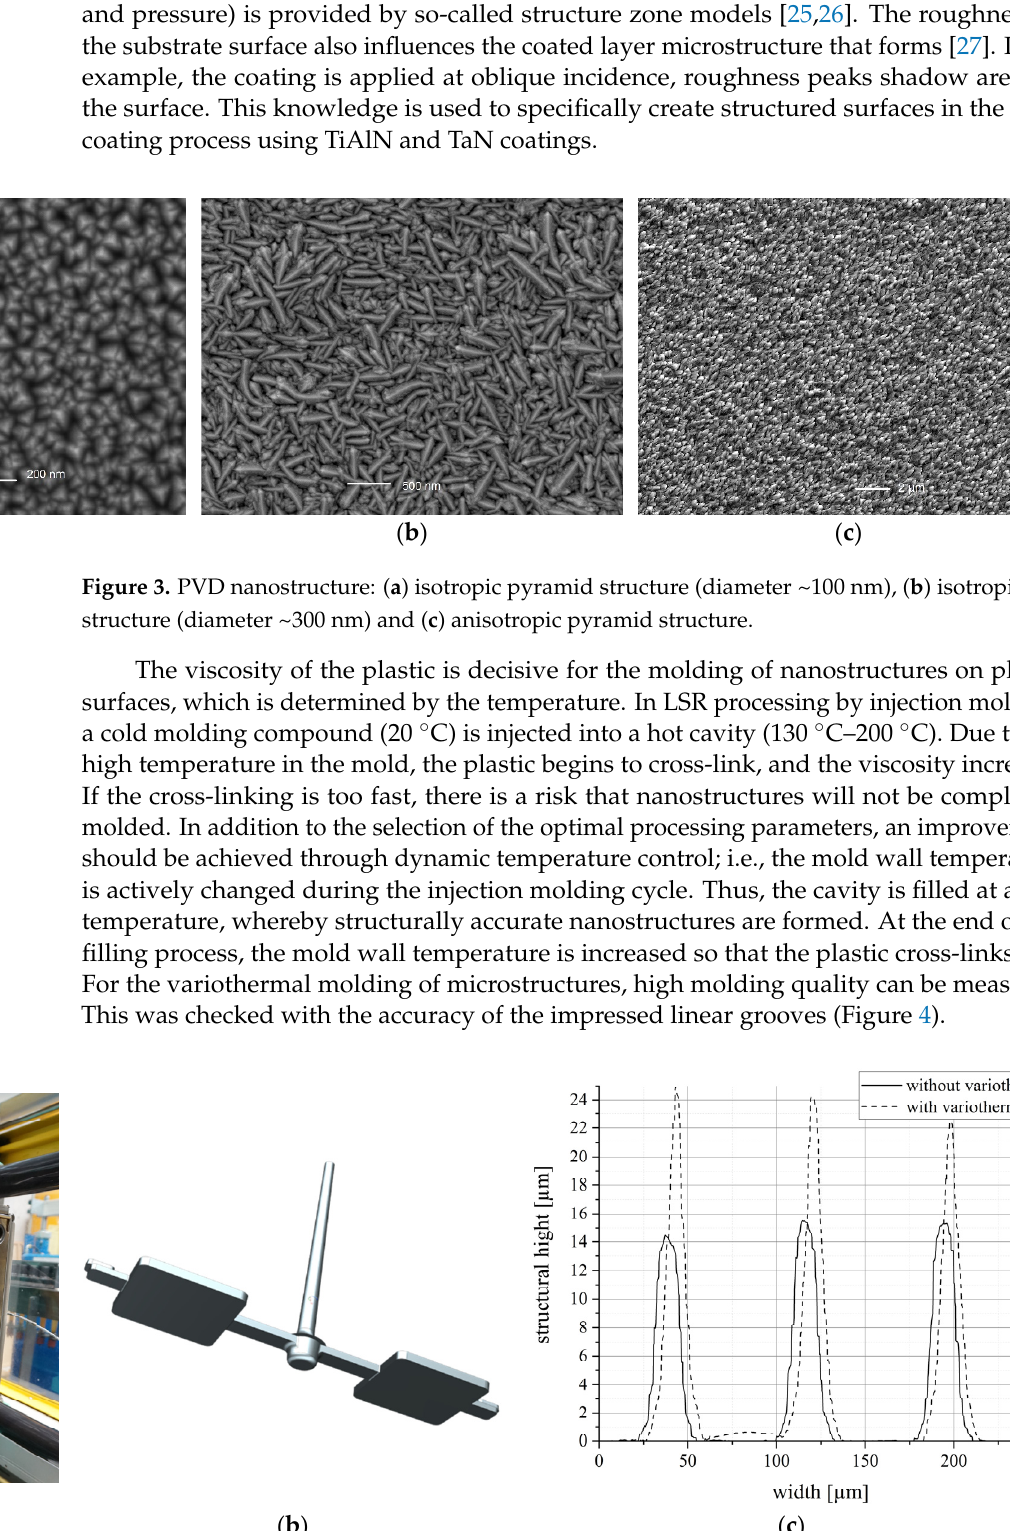
Figure 2. Laser-ablated steel surfaces: ( a ) after directional ablation, ( b ) and ( c ) bi-scale structure of isotropic pyramids on laser-ablated surfaces.